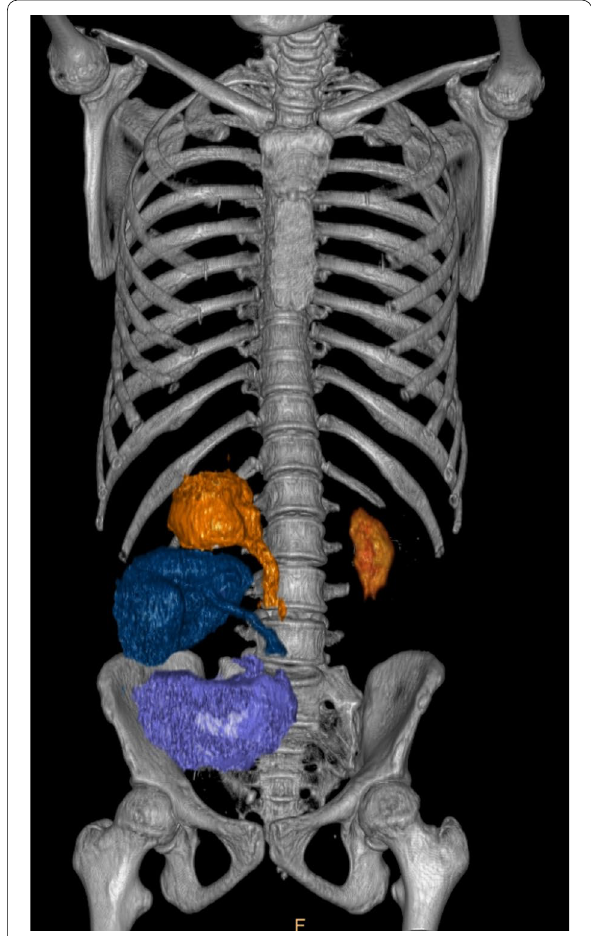
Fig. 1 CT reconstruction showing the patient’s native kidneys (orange), the right flank transplanted kidney (blue) and the right iliac fossa transplanted kidney